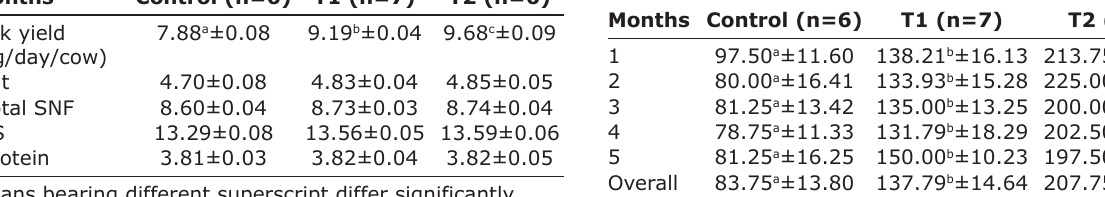
Table-1: LSQ mean±SE of milk yield and milk composition of Jersey crossbred cows. Months